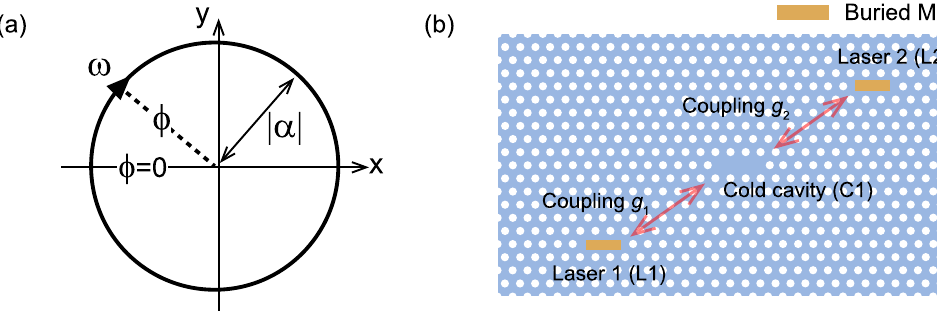
√ ε/β and phase φ = ω t √ ε/β( − cos φ , sin φ) , where x and y are the